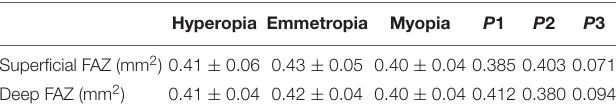
TABLE 3 | The comparisons of superficial and deep foveal avascular zone among hyperopia, emmetropia, and myopia groups. Hyperopia Emmetropia Myopia